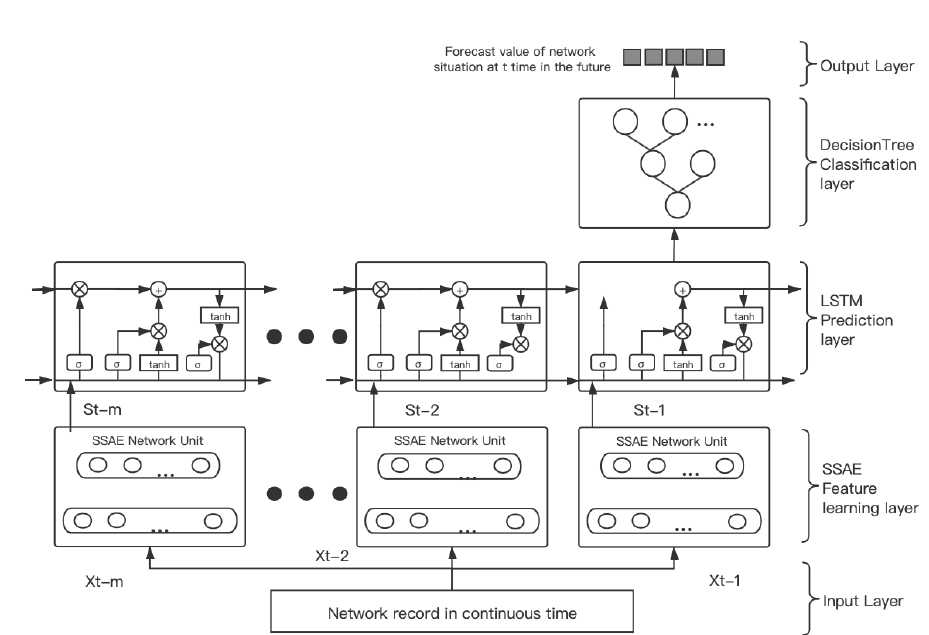
Figure 3. The structure of LSTM-DT network security situation awareness